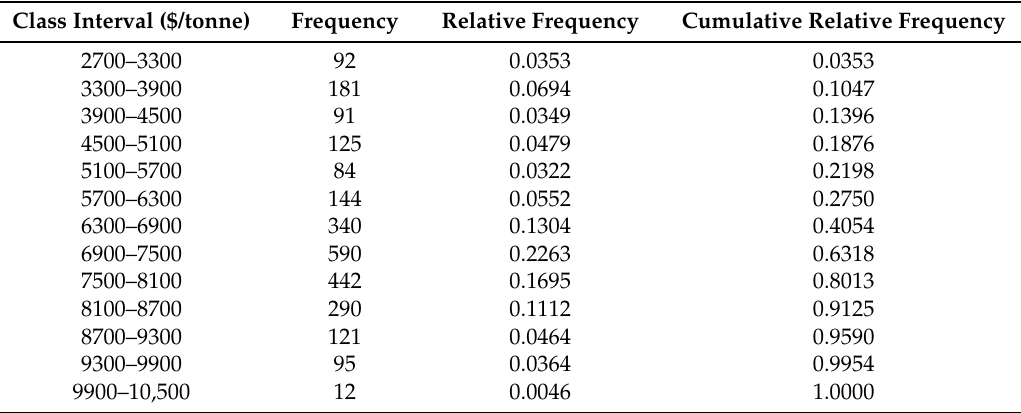
Table 1. Cumulative relative frequency of copper prices.